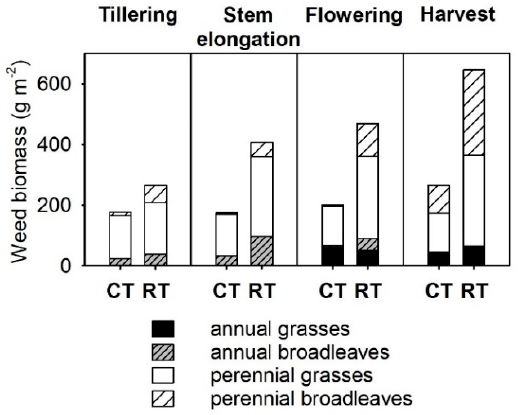
Figure 1. Weed biomass of four different growing form types (g fresh matter m − 2 ) per tillage system (weed-infested treatment only) at different wheat stages. Fertilisation treatments were pooled. CT = ploughing, RT = reduced tillage.